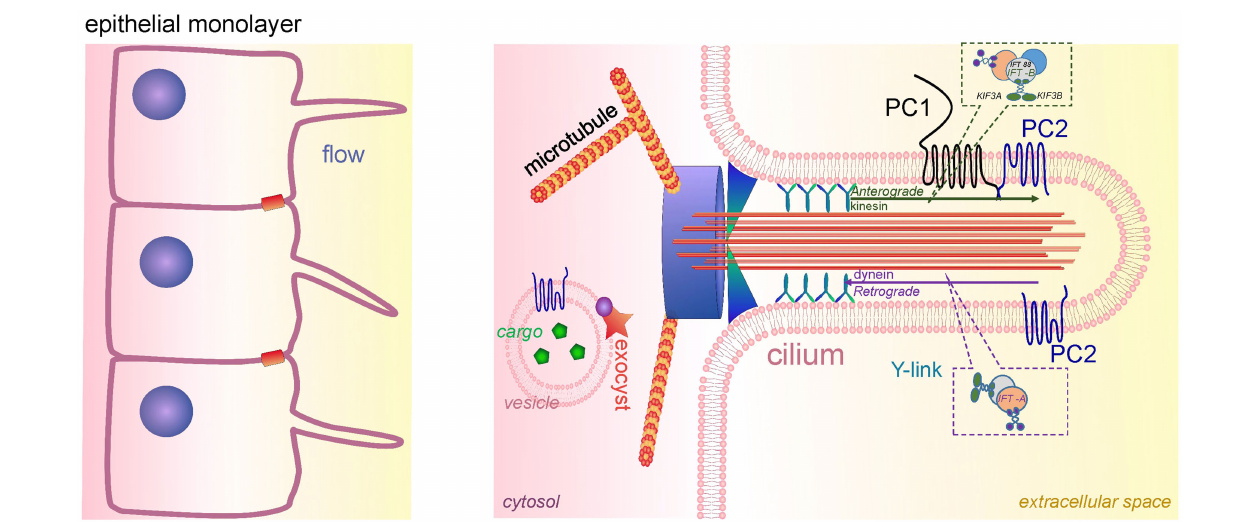
FIGURE 3 | Cilia in PKD development. A schematic of the renal epithelium with cilia is shown on the left. An expanded detailed schematic of primary cilium is shown on the right. The major components of primary cilium are basal body, transition zone, axoneme, cilium membrane, and plasma. The basal body is a base of cilia that contains a lot of ciliary proteins; nine doublet microtubules extend from the basal body, forming the axoneme enclosed by the ciliary membrane and ciliary plasma. Transition zone (TZ) is a diffusion barrier which plays a critical role in ciliogenesis. TZ is formed by Y-shaped fibers, which connect axonemal microtubules to the ciliary membrane. The intraflagellar transport (IFT) system (includes anterograde and retrograde transport) is necessary for ciliary transport and cilia growth. IFT system consists of two protein complexes, IFT-A and IFT-B. The IFT-B core complex includes at least 14 IFTs, and one of the most well-studied ones is IFT88. The membrane of the cilium contains PC1/PC2 complexes, which are a part of the mechanosensitive unit of cilia. The protein complex exocyst is an important component of ciliary function; exocyst mediates the tethering of transport exocytic vesicles to the plasma membrane prior to fusion. Genetic defects in ciliary genes can cause